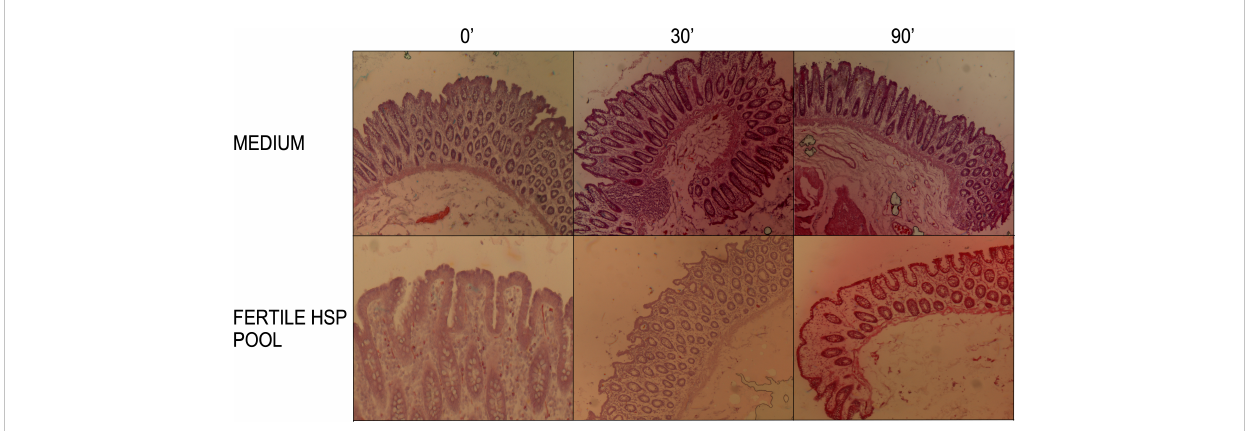
FIGURE 3 Histological analysis of colon sections. Hematoxylin-eosin staining was performed on tissues at the beginning of the experimental procedure (T0), and after 30 and 90 minutes of treatment with either medium or the HSP pool from fertile donors. Shown are 4x objective magni fi cation. Representative images from Hematoxylin-eosin stained colon sections (10 µm thickness) showed no morphological differences in medium compared to HSP treated tissues. Preserved epithelial luminal contour, lamina propria, muscolaris mucosae and submucosa were observed in all